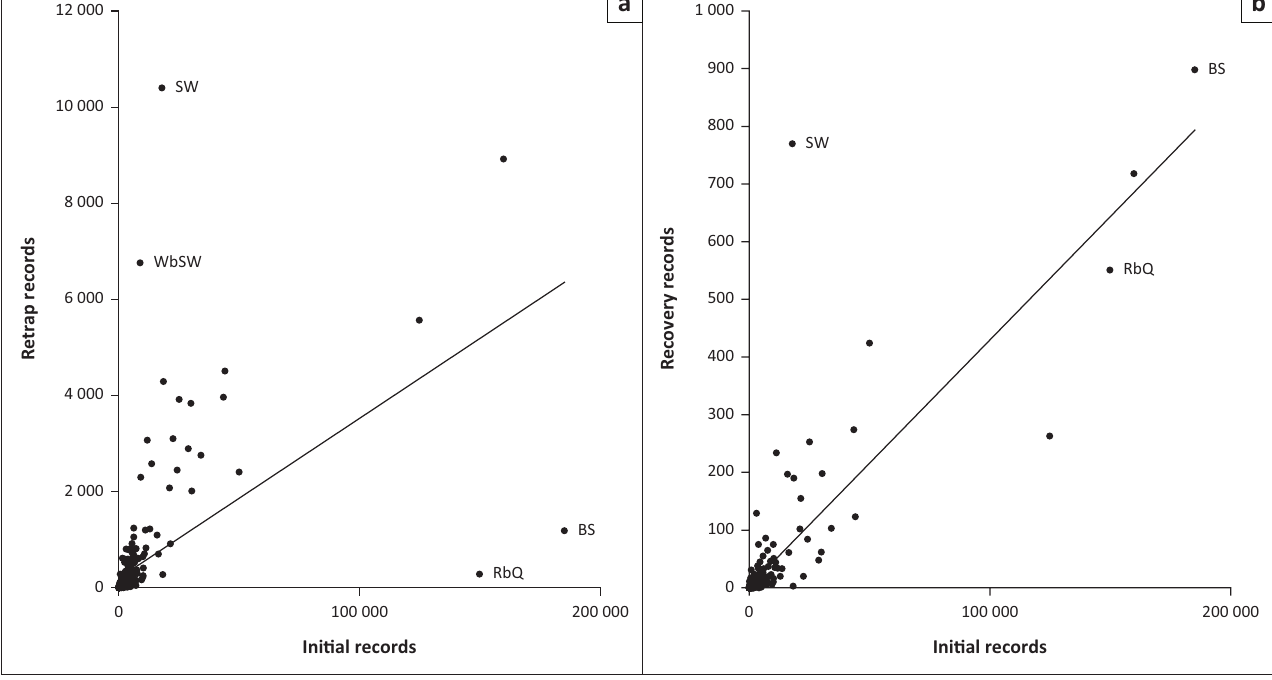
FIGURE 3: (a) Number of initial ringing records compared to retrap and (b) recovery records of each Passeriforme species (linear trend line displayed). Outlier points are SW, Sociable Weaver, WbSW, White-browed Sparrow-Weaver, RbQ, Red-billed Quelea, BS, Barn